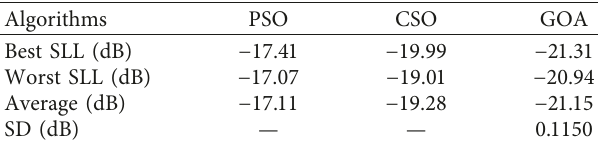
Table 2: The comparison of algorithms’ performance for 10-ele- ment linear array in 20